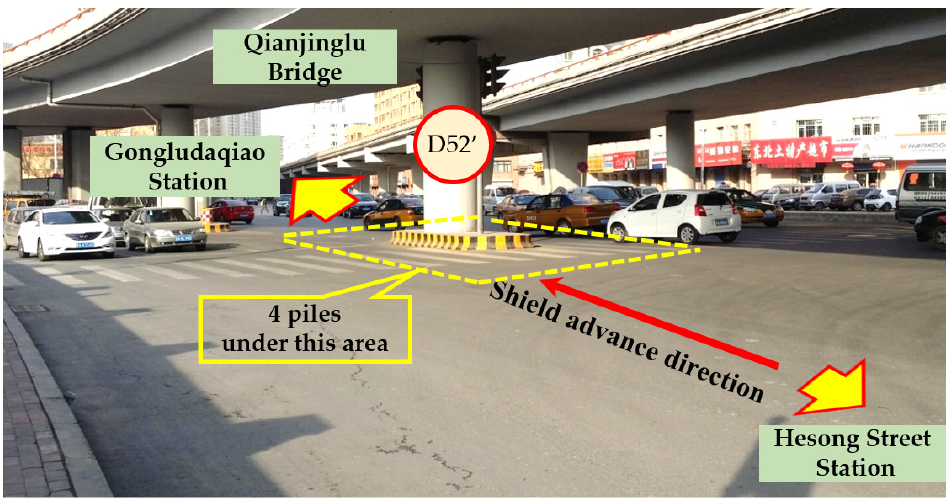
Figure 1. Plan of the project.